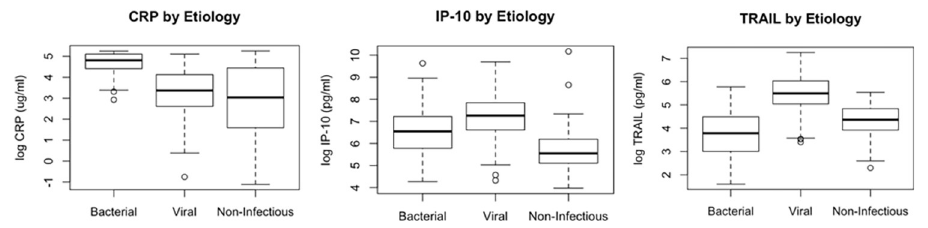
Fig 3. Log concentrations of CRP, TRAIL, and IP-10 stratified by clinical category. Data are presented as a box and whisker plot showing medians with interquartile ranges.